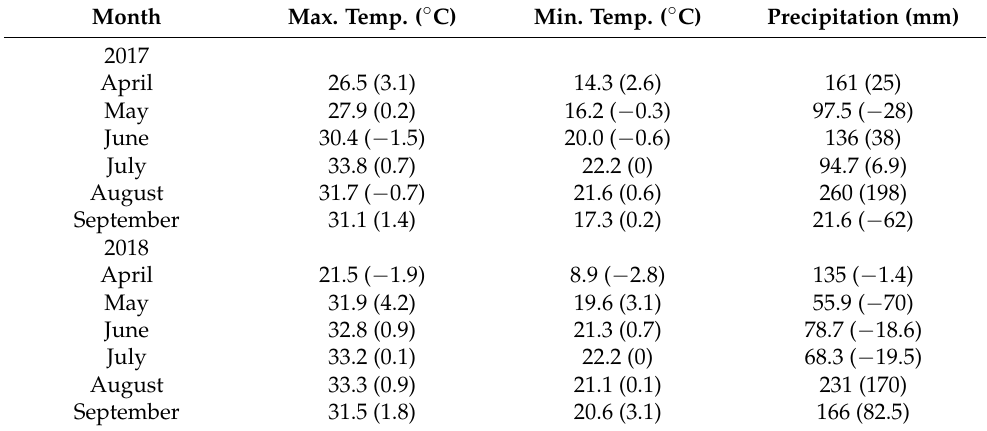
Table 4. Maximum and minimum air temperature ( ◦ C) and precipitation (mm) of the weather station (Stoneville, MS, USA) close to experimental field during 2017 and 2018 growing seasons, values in bracket indicate deviation from 30 yr.